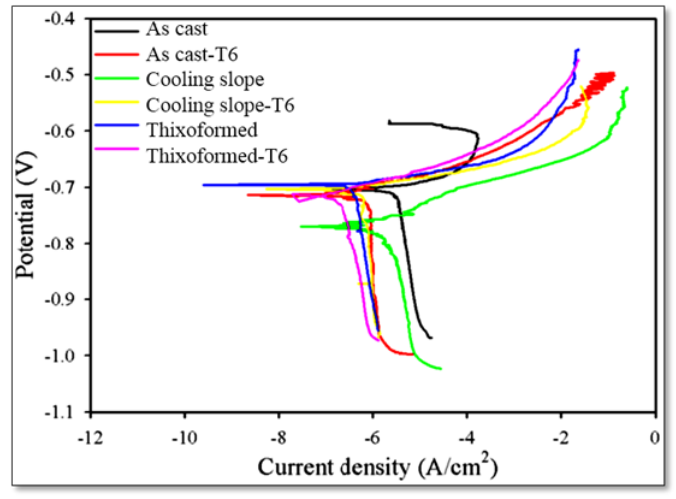
Figure 9. Polarization curves of Al–7%Si alloy before and after heat treatment in 3.5 wt.% NaCl. Table 3. Average of corrosion rate (CR), current density ( i corr.) and polarization resistance (R p ). Samples